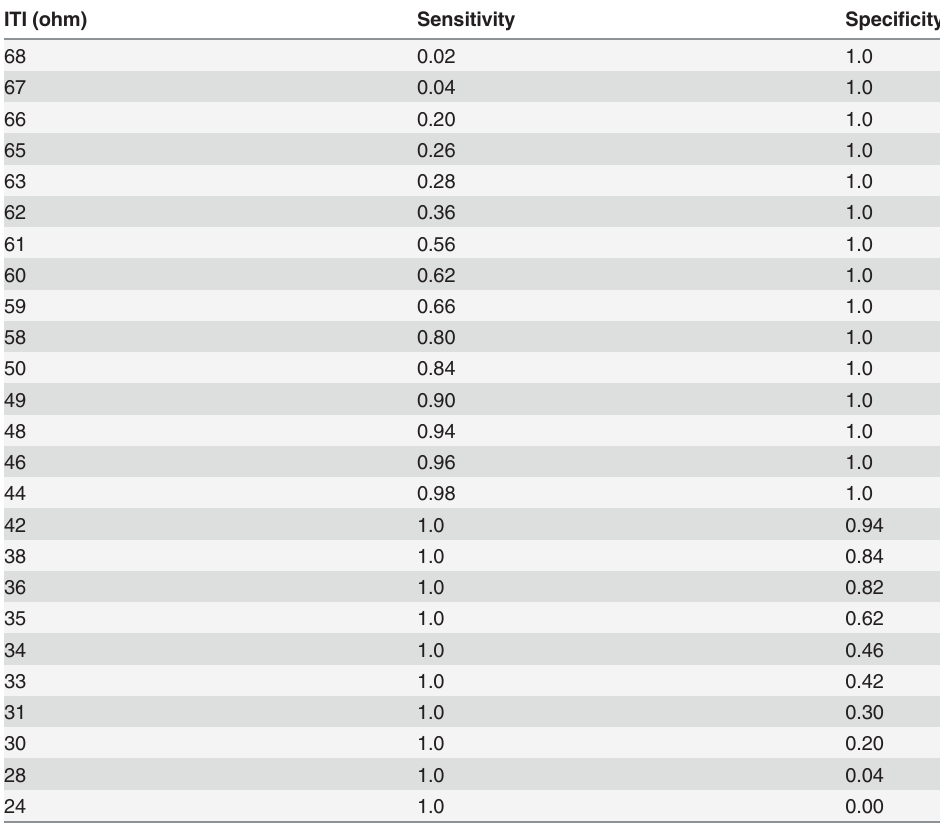
Table 3. Sensitivity and specificity of baseline ITI